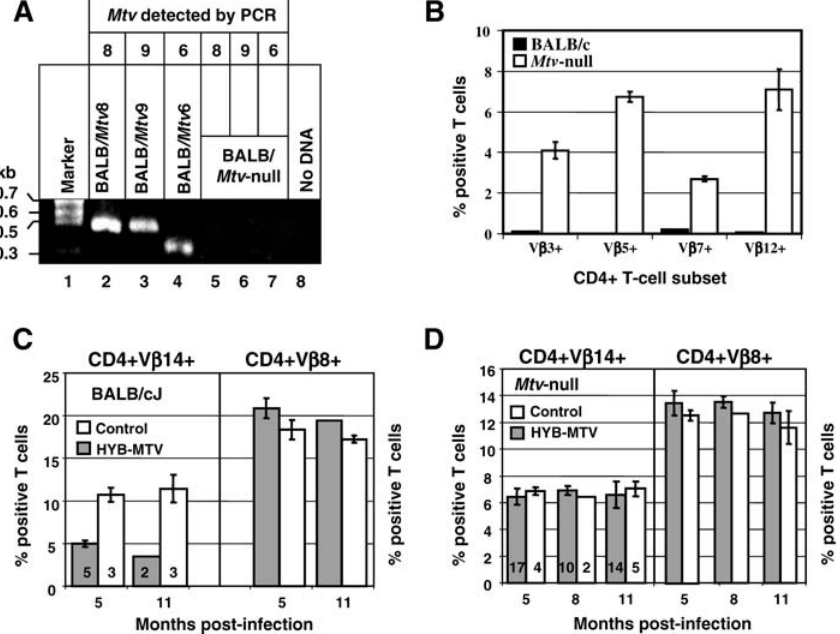
Figure 1. BALB/ Mtv -Null Mice Lack Endogenous Mtv s and Have Impaired Sag-Mediated T-Cell Deletion after Exogenous MMTV Infection (A) PCR analysis of mouse genomic DNA using endogenous Mtv -specific primers. Genomic DNA samples from mice with single endogenous Mtv s were used as positive controls for PCR amplification of individual proviruses (lanes 2–4). Genomic DNA samples from three Mtv- null mice were analyzed (lanes 5–7). PCR with no added DNA template was the negative control (lane 8). (B) Flow cytometry of endogenous Mtv Sag-reactive T-cell subsets in PBLs. PBLs from 6-mo-old BALB/c and Mtv -null mice were dually stained